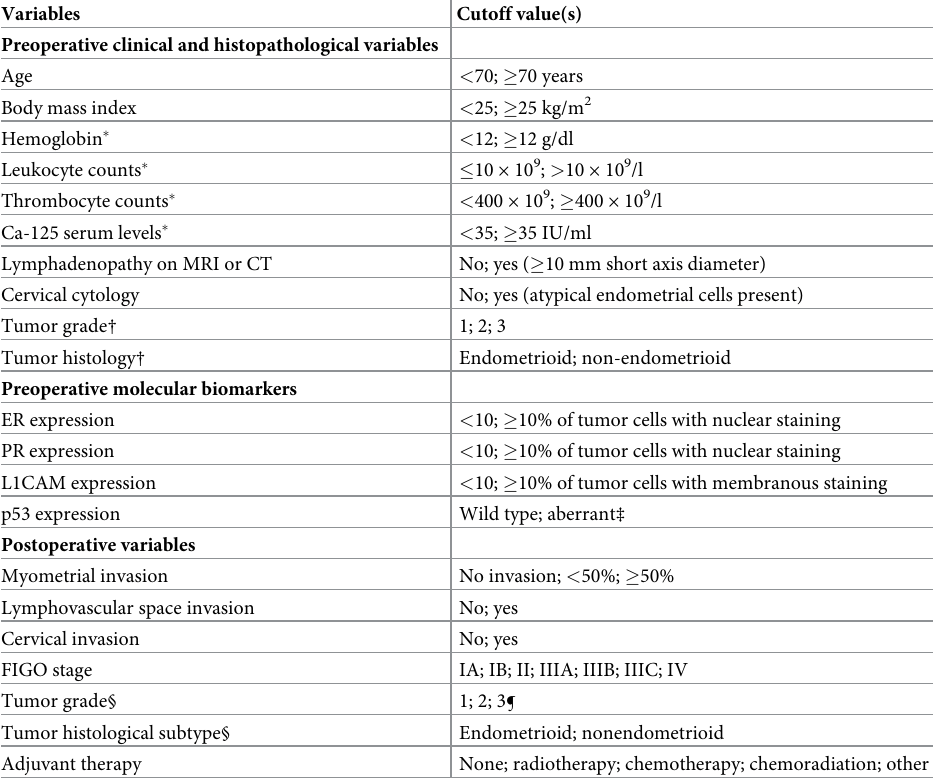
Table 1. Candidate variables for the construction of the